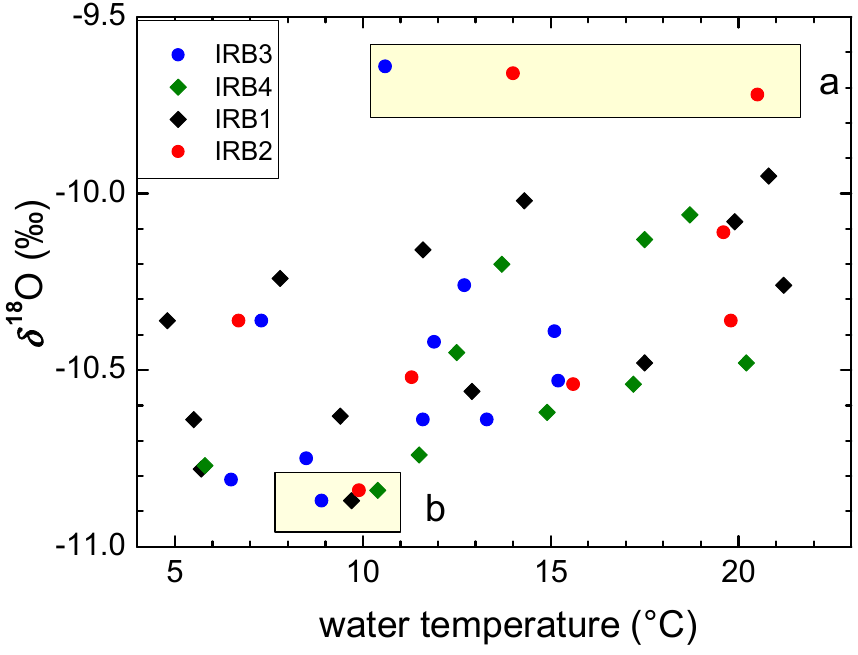
Figure 16. A relation of the δ 18 O vs. water temperature for lake waters, 2012–2014. Group a : after heavy summer rains; group b : after abundant winter precipitation and snow melting.